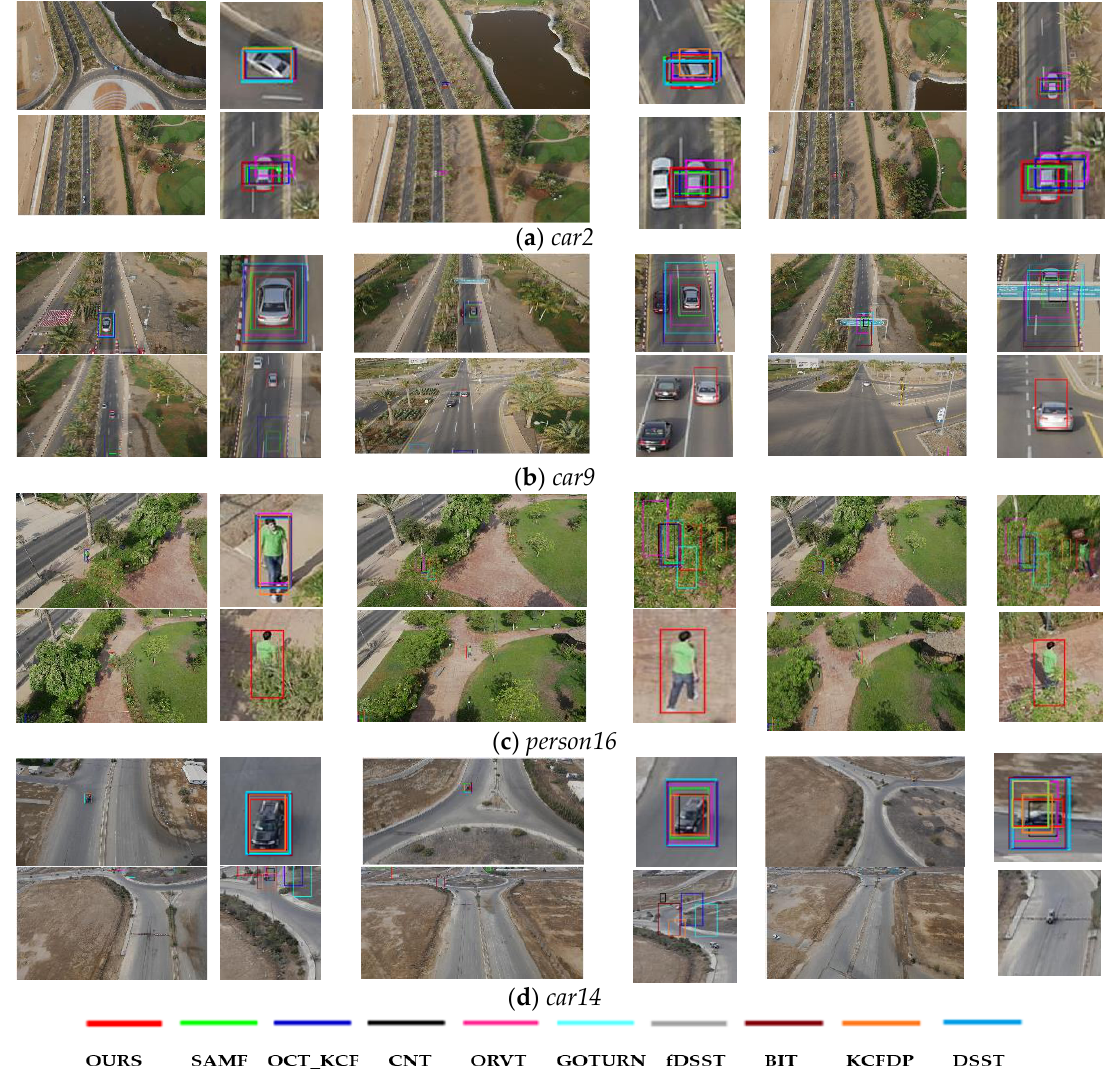
Figure 8. Tracking results of different methods on four representative sequences.